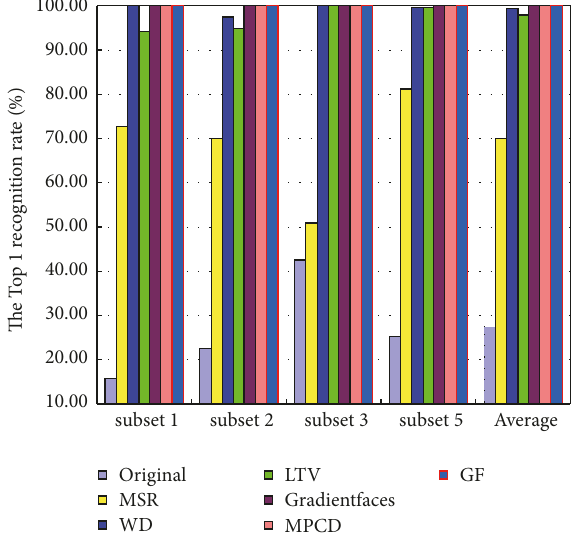
Figure 7: Comparisons on the Top 1 recognition rate (the subset 4 used as the training set).